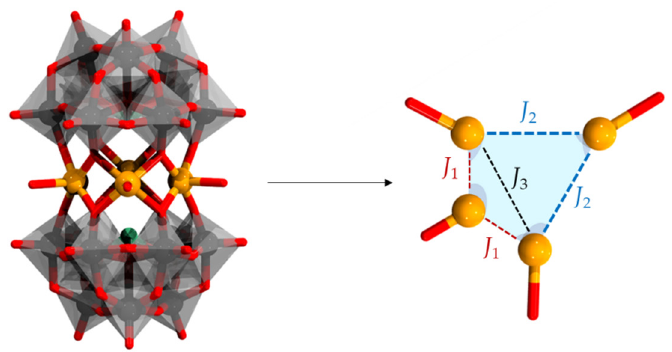
Figure 10. Polyanion [Cu 4 (H 2 O) 4 ( α -AsW 9 O 33 ) 2 ] 10 − ( left ) and its {Cu} 4 core ( right ) depicting three different couplings ( J 1 , J 2 and J 3 ). Color code: As = green, Cu = orange, {WO 6 } = gray octahedra, W = black, and O = red.